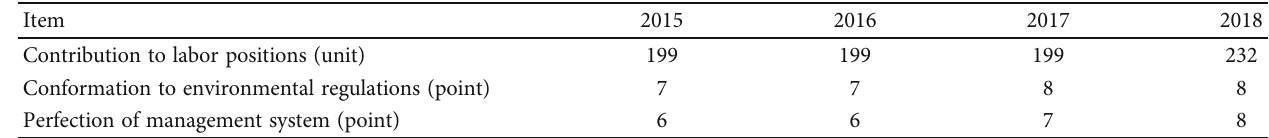
Table 12: Social impact index value.